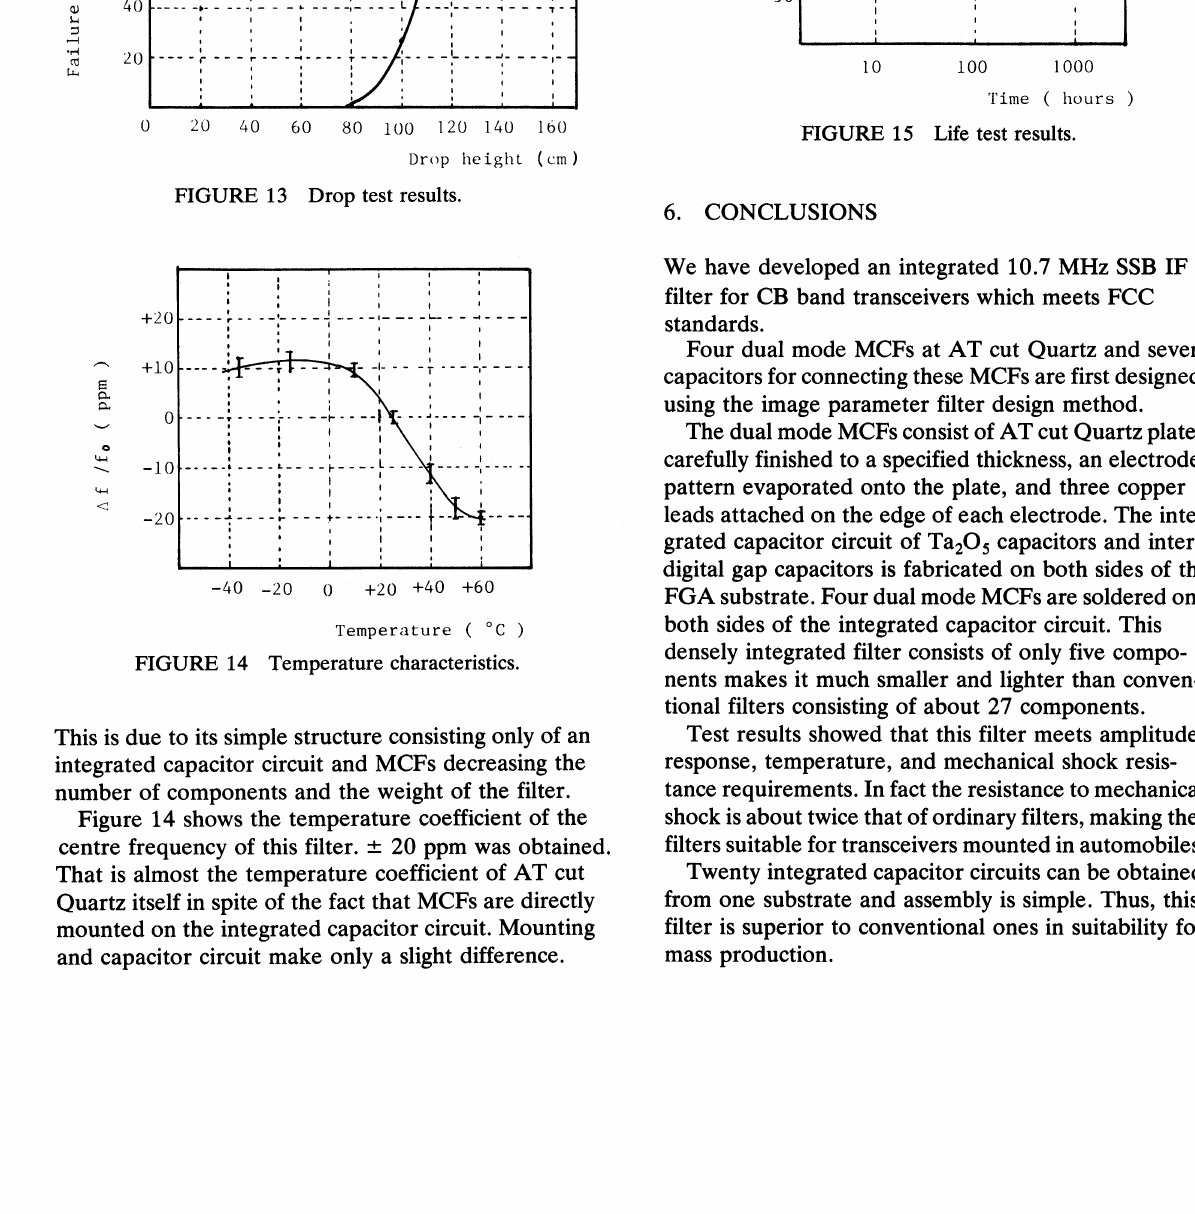
FIGURE 15 Life test results,